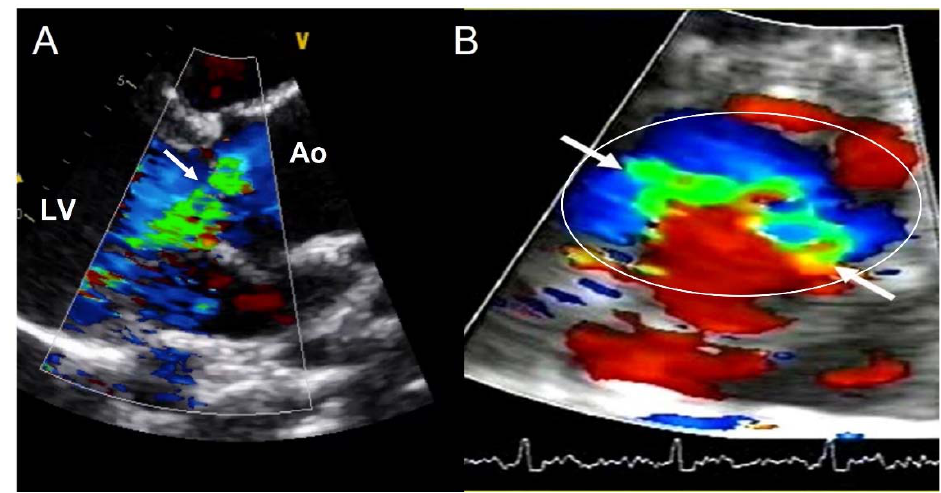
Figure 5. Severe aortic regurgitation in a BAV. ( A ) Eccentric jet in parasternal long axis ‐ view (arrow). ( B ) The short ‐ axis view shows the elliptic shape of the regurgitant orifice (arrows) in the aortic annulus (circle). Ao—aorta; LV—left ventricle.